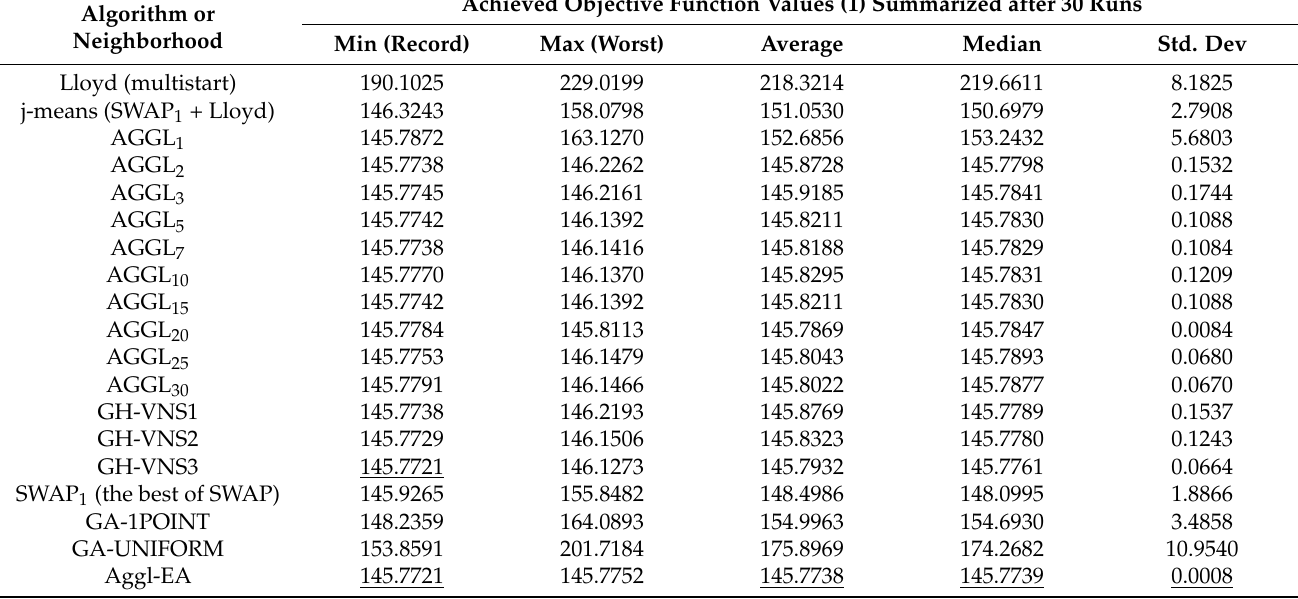
Table A9. Comparative results for Mopsi-Joensuu dataset. 6014 data vectors in R 2 , p = 30 centers, time limitation 5 s. Algorithm or